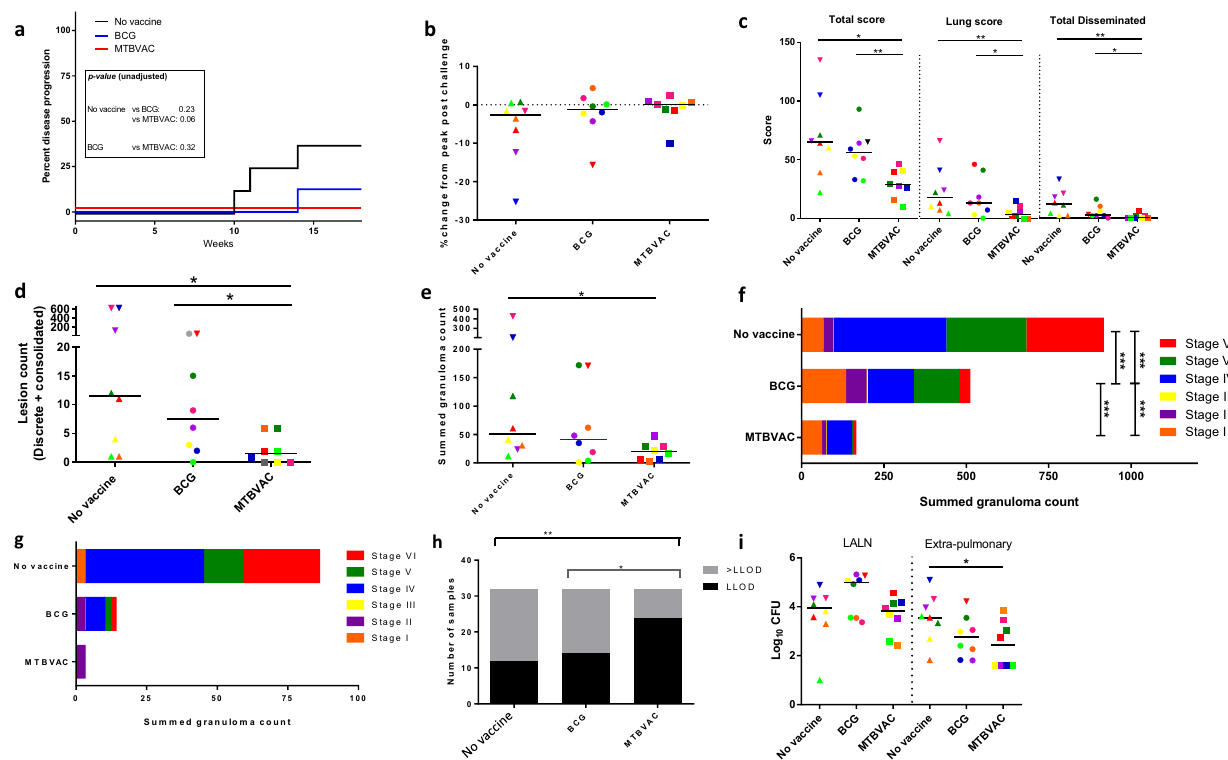
Fig. 2 Tuberculosis-induced disease burden. a Kaplan – Meier plot showing the development of progressive disease to a level that met humane endpoint criteria in vaccinated and unvaccinated macaques after challenge with M. tuberculosis . Unadjusted P values from log-rank comparisons are shown. b Change in body weight expressed as a percentage of the peak weight measured during the post-challenge study period. c Total, pulmonary and disseminated (spleen, liver, kidneys) tuberculosis-induced disease burden measured using a gross pathology score system. d The number of macroscopic lesions in the lungs following serial sectioning. e Total number of granulomas (stage I – VI combined) identi fi ed in the lung from representative H&E-stained sections. f Total number of granulomas (stage I – VI combined) identi fi ed in the lung from representative H&E-stained sections where stacked bars indicate the number of granulomas at each stage I – VI and the combined total within each experimental group. g Total number of granulomas (stage I – VI combined) identi fi ed in the extrapulmonary tissues (spleen, liver, kidneys) from representative H&E-stained sections. h The proportion of tissue samples cultured from which M. tuberculosis was isolated (>LLOD: CFU value greater than the lower limit of detection of the assay; LLOD: value recorded as the lower limit of detection of the assay). i Bacterial burden determined in lung-associated lymph nodes (LALN) and extrapulmonary tissues. The colour and symbol coding per individual is consistent throughout and between fi gures. Upside down triangular symbols indicate animals in which disease progressed to meet humane endpoint criteria. Non-parametric Mann – Whitney U tests were used for group-wise comparisons of pathology scores, granuloma/lesion counts and viable CFU counts recovered from tissues, with unadjusted results reported as: * P ≤ 0.05; **P ≤ 0.01 . Χ 2 tests were used to compare the proportion of tissues with viable M. tuberculosis CFU counts above or below the LLOD of the assay between vaccination groups and Cochran – Armitage method Χ 2 tests to compare granuloma stage scores between groups, unadjusted results are reported as * P ≤ 0.05 ; **P ≤ 0.01; ***P ≤